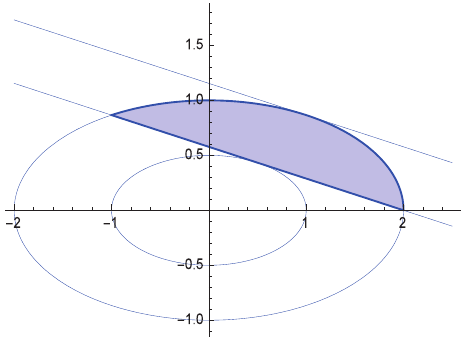
√ √ 3/2 ) , v = ( 1/2, 3/4 ) and g ( x , y ) = x 2 /4 + y 2